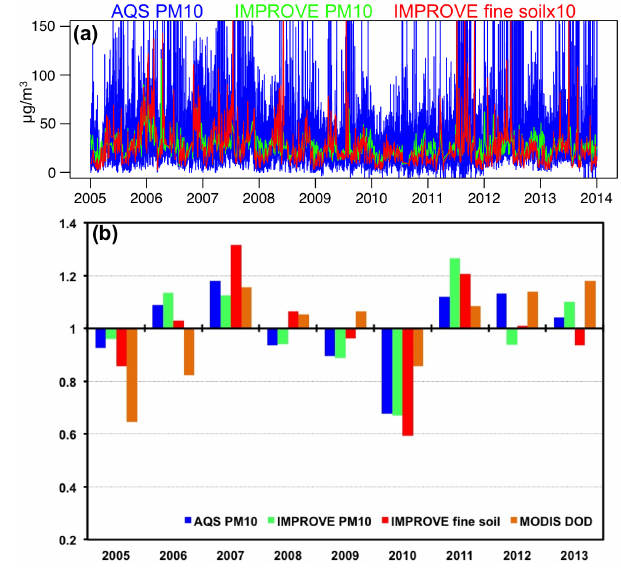
Figure 4. Time series of surface PM data at AQS and IMPROVE sites in Phoenix. These observations are shown in their original tem- poral resolution in (a) , and their anomalies in each year’s dust sea- son are shown in (b) , along with the Aqua MODIS DOD anomalies (i.e., the annual mean value over the multi-year mean